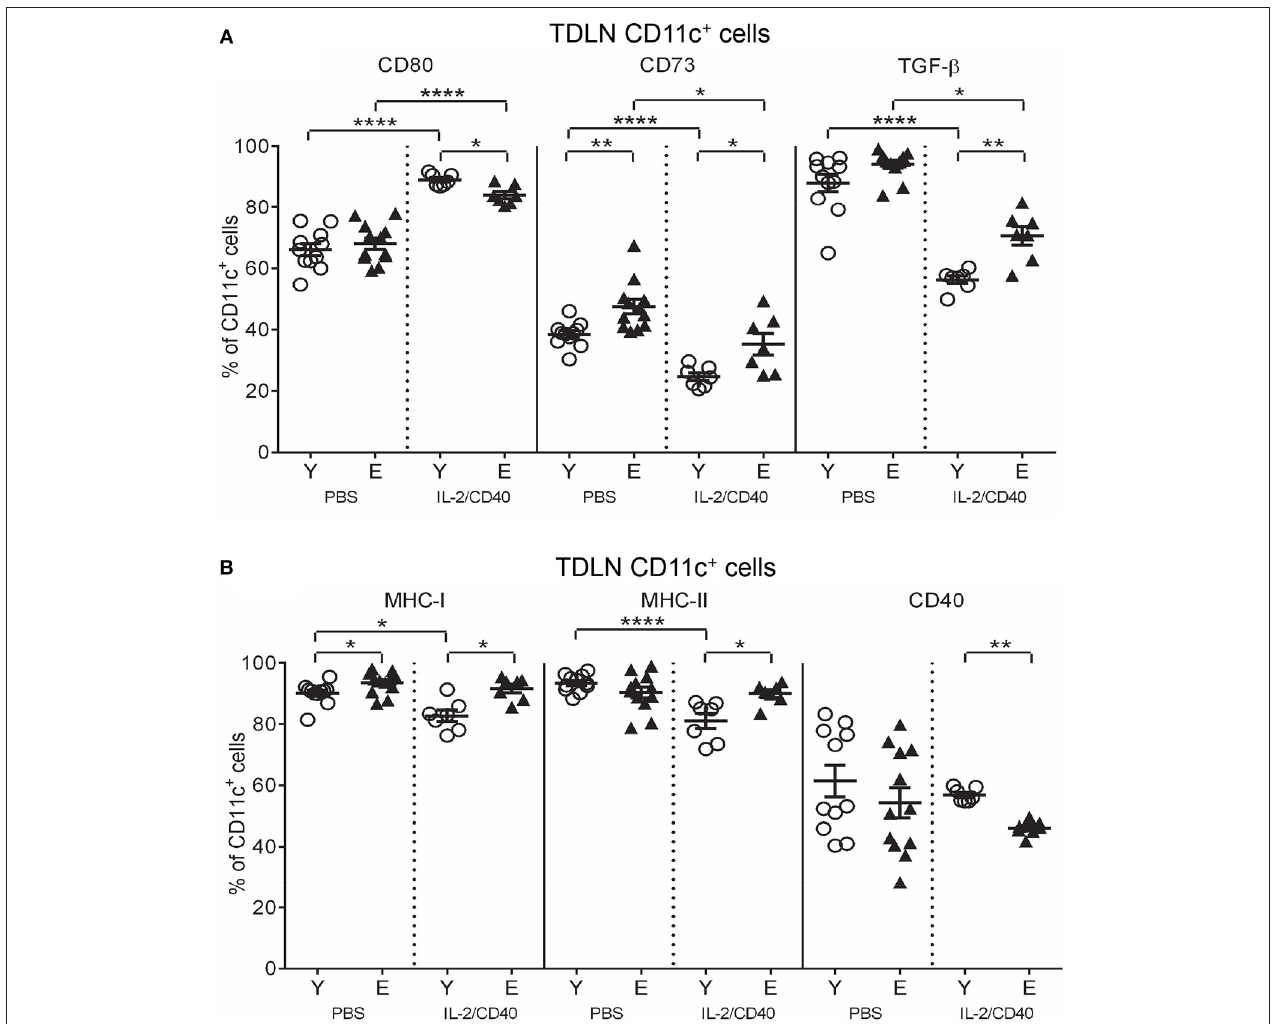
FIGURE 6 | IL-2/CD40 increases MHC-I/II, CD80, CD73, and TGF- β on TDLN CD11c + cells. After two doses of IL-2/CD40 or PBS diluent, percentages of CD11c + cells positive for CD80, CD73, and TGF- β (A) and MHC-I, MHC-II,. and CD40 (B) were measured in TDLNs from the young and elderly tumor-bearing mice described in Figures 5B,C using flow cytometry. Data are shown as mean ± SEM, n = 7 young and n = 7 elderly IL-2/CD40-treated mice, n = 11 young and n = 12 elderly PBS control mice, * p < 0.05, ** p < 0.005, **** p < 0.0001 comparing (i) young to elderly mice, or (ii) IL-2/CD40-treated mice to age-matched PBS control mice.